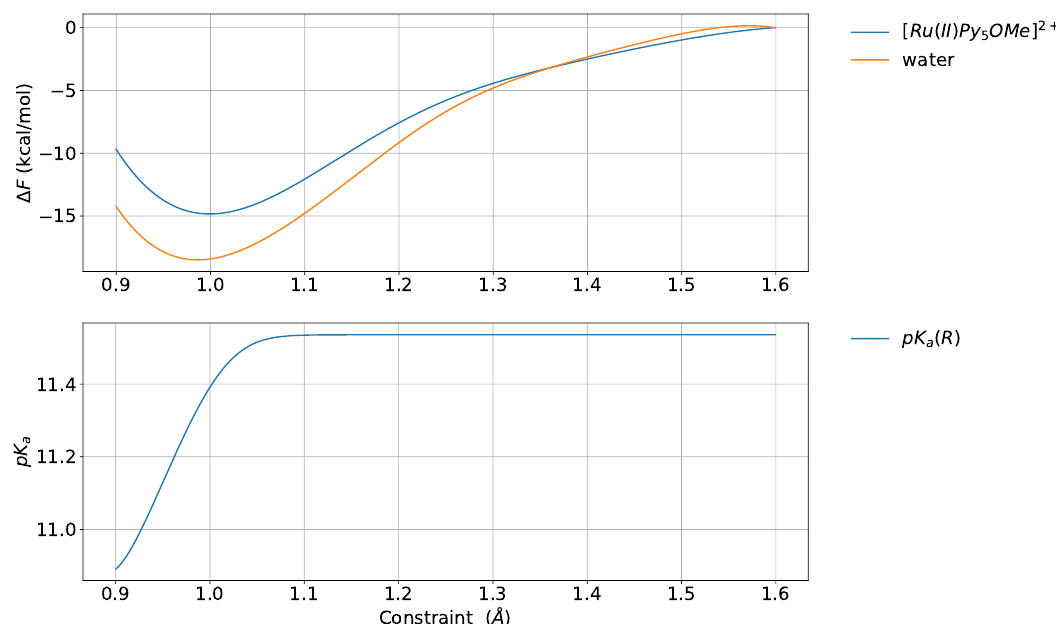
Figure 7. Relative p K a as a function of d(A–H) according to Equation (6), the value asymptotically approaches a constant